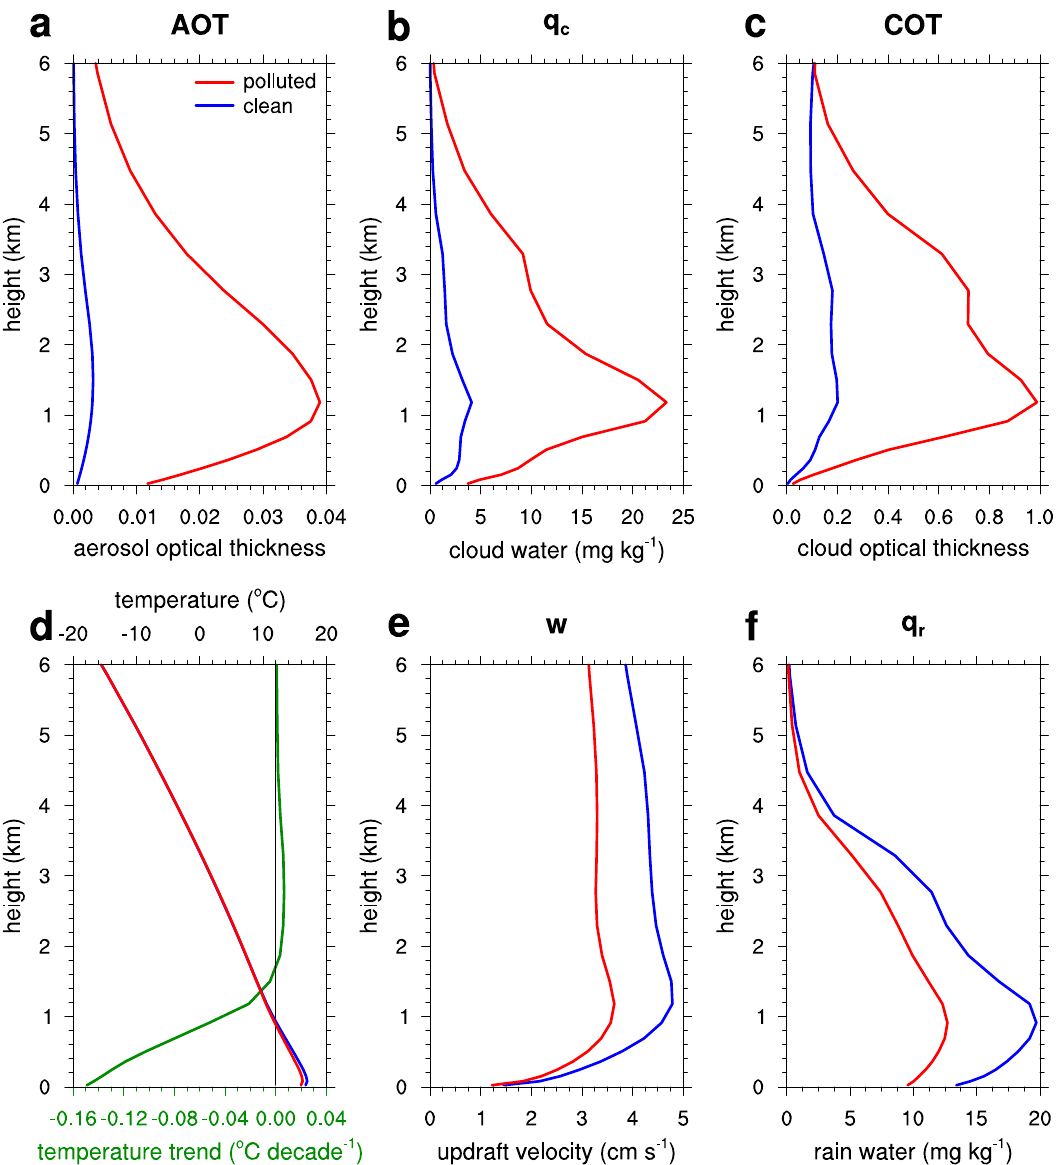
Fig. 4 Impacts of aerosols in the vertical direction. March – April mean vertical pro fi les of ( a ) aerosol optical thickness (AOT) at 400 nm, ( b ) cloud water mixing ratio, ( c ) cloud optical thickness (COT), ( d ) air temperature (read the top axis) and scaled temperature trend (in green, read the bottom axis), ( e ) in-cloud updraft velocity, and ( f ) rain water mixing ratio in the HIGH T POLLUTED and HIGH T CLEAN simulations in 2018. All variables are averaged over central-east China (marked by the purple rectangle in Fig. 2d), and updraft velocity is averaged over cloudy grids at which the total-column cloud water mixing ratio is >10 mg kg − 1 . For AOT and COT, only daytime values are